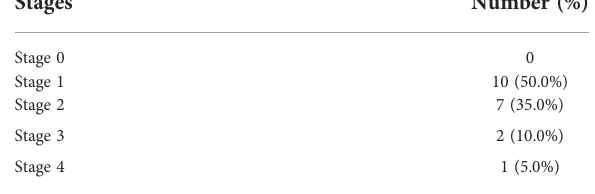
TABLE 4 PVD stages at baseline.